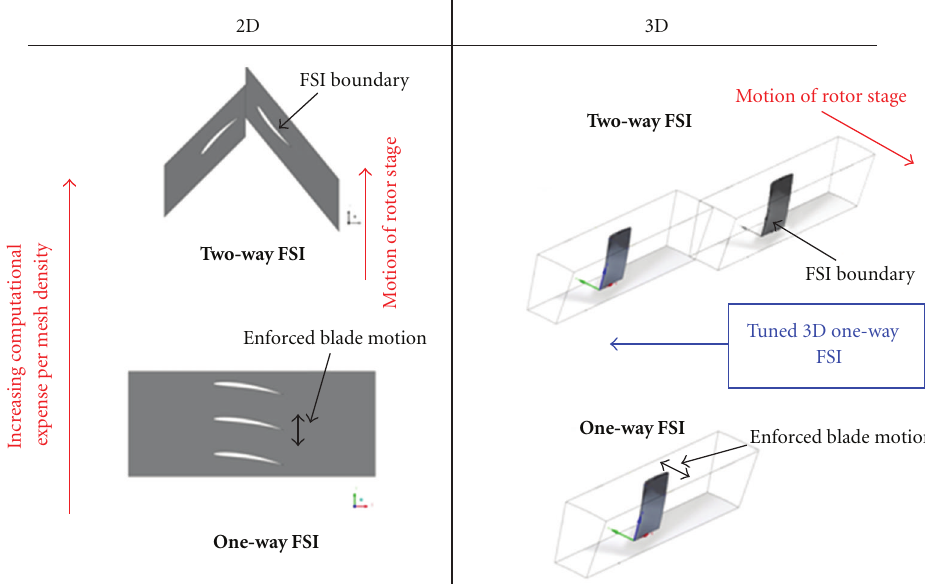
Figure 3: Schematic of di ff erent FSI numerical modelling procedures for gas turbines. The simplified tuned model used within this work lies between 3D One-way FSI and 2D Two-way FSI in computational expense for the same mesh